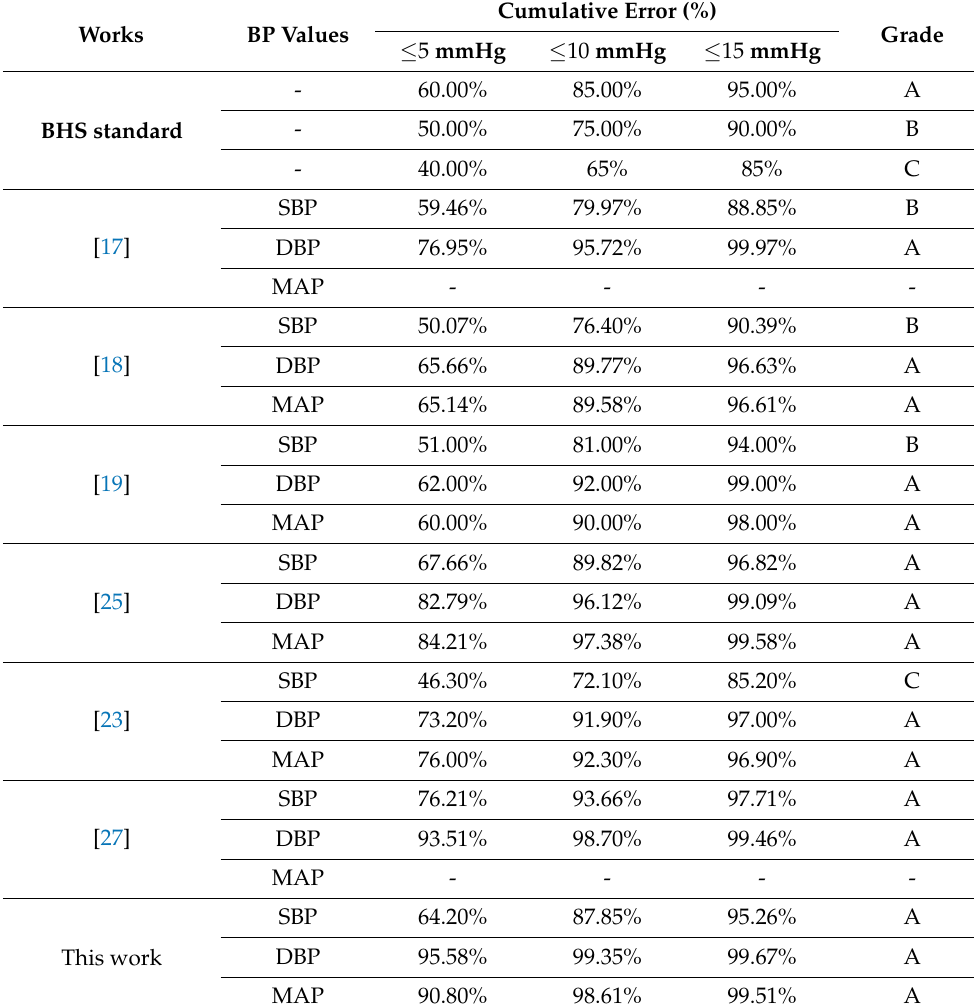
Table 4. Comparison with related works based on British Hypertension Society (BHS)